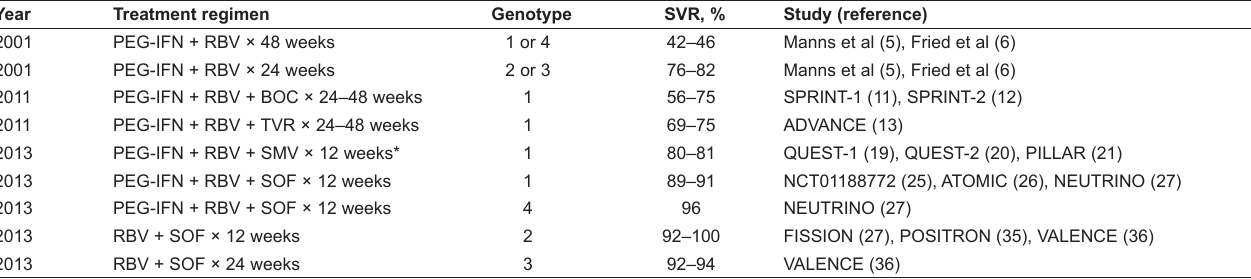
TAble 1 Currently approved hepatitis C treatment regimens